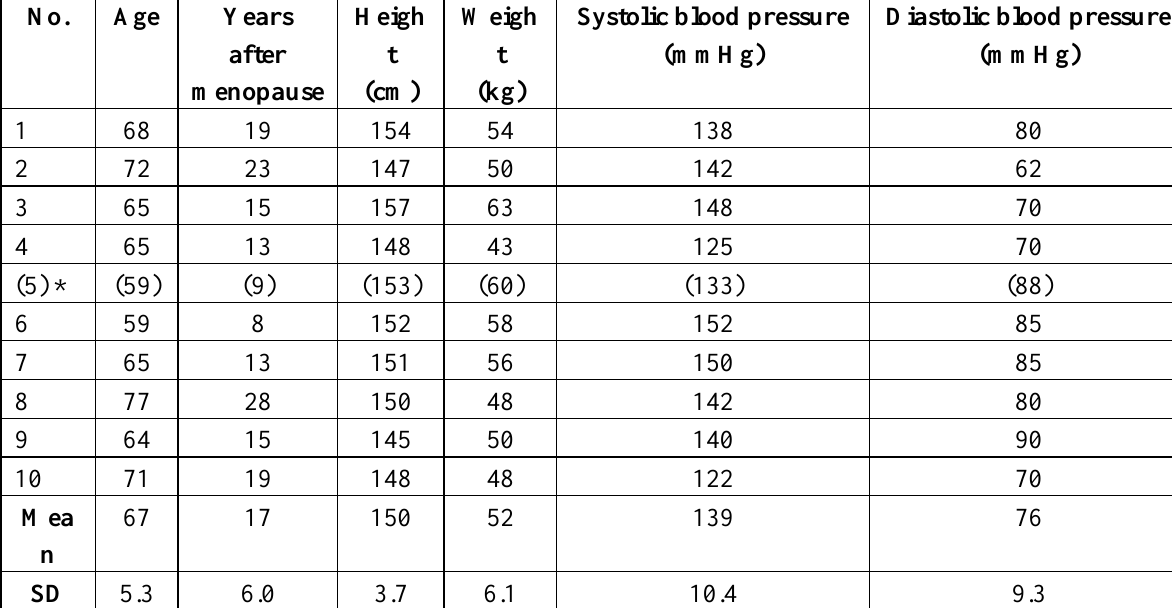
Table 1. Background of the test